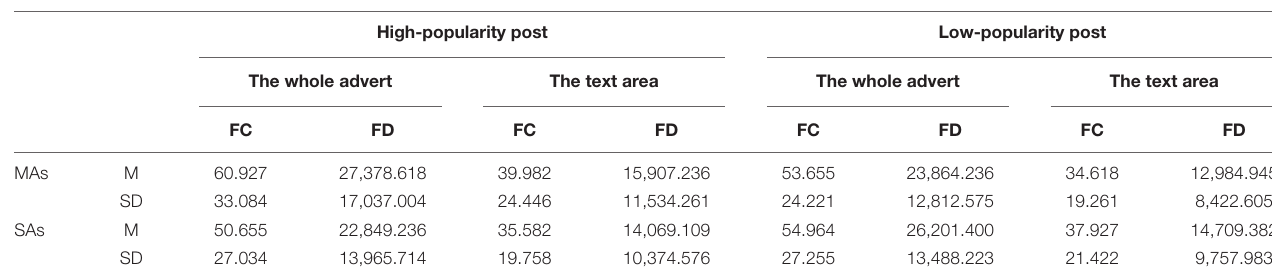
FIGURE 1 | Flowchart of eye movement experiment for a single trial. TABLE 1 | Descriptive statistics of eye movement